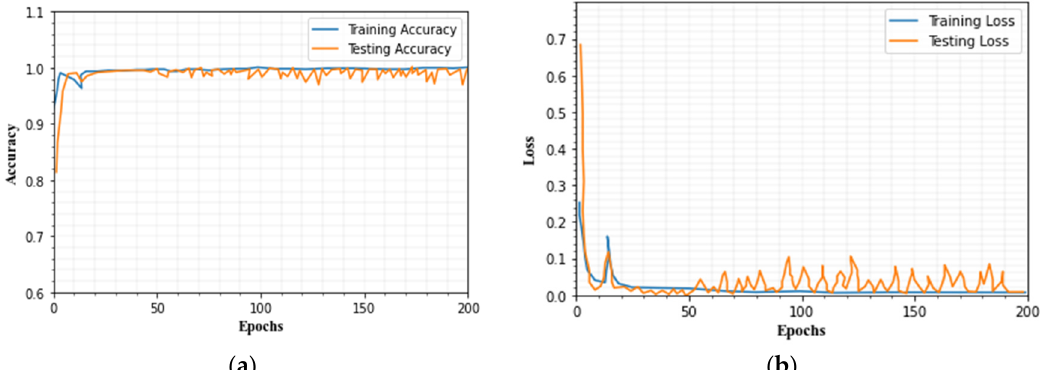
Figure 16. ( a ) Testing and training accuracy, ( b ) testing and training loss for CICIDS2019 dataset.